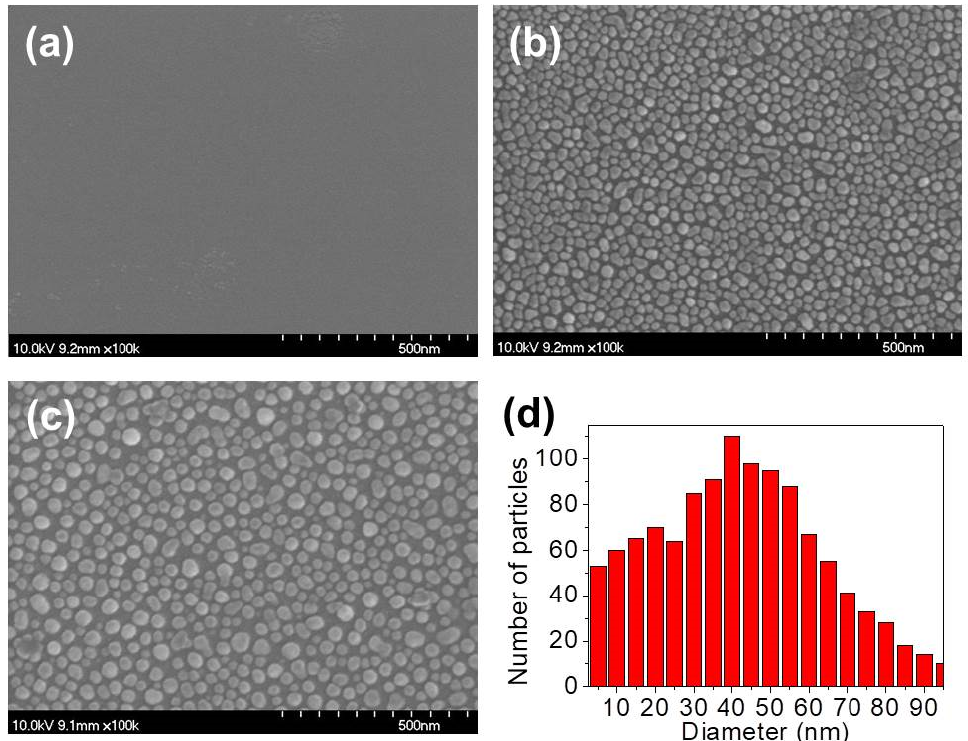
Figure 2. Surface SEM images of ( a ) the bare glass, ( b ) the 5-nm-thick Ag thin film and ( c ) the Ag nanoparticles after annealing at 300 °C for 10 min. ( d ) Diameter distribution of the Ag nanoparticles.